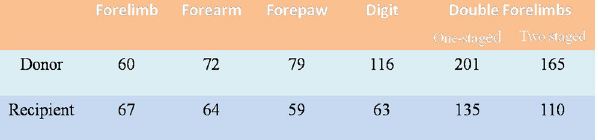
thoracoacromial, and thoracicdorsal vessels. The anatomical locations and diameters of the axillary vessels were consistent. They could also be used as a vascular pedicle for the forelimb, forearm, forepaw and digit ectopic implantation. The main vessels supplying the forearm part are branches from the axillary vessels extending to the elbow, as well as the branches of the brachial vessel including deep brachial vessels, some small branches to the elbow joint, and cutaneous branches to the overlying skin. The anatomical location of the pedicle was superficial and consist- ent. The pedicle was approximately 3 cm in length, making it easier for anastomosis use. The major vessels supplying the forepaw were branches from the axillary vessels and brachial vessels extending to the forepaw. The main branches from the brachial vessel in the forearm region were the median and ulnar ves- sels, whose subsequent branches included the interosseous vessels responsible for partial blood supply for elbow joint, and other branches which supply forelimb muscles. The average length of the pedicle was about 5 cm. The ulnar vessel runs between the ulna and superficial head of flexor digitorum profundus, then accompanies the ulnar nerve to the manus. The median vessel runs along the medium nerve and between the flexor carpi radialis and the superficial head of flexor digitorum profundus. Both vessels became superficial at the distal part of the forearm. The saphenous vessels had three main branches at the inferior margin of the adductor muscles. The most supe- rior of these runs anterior to the tibia and supplies all digits, while the other two branching vessels run medially along the forearm and extend branches to the muscle, joints, and skin. Both run along the tibia nerve and curve posteriorly to the malleolus medialis, then run along the medial side of the plantar surface, where they merge into the medial plantar vessel. The medial plantar vessel divides into four branches at the midpoint of metatarsals, the first of which supplied blood to hallux. The number and location of the vessels that supplied the hallux was consistent. The external jugular vein and the axillary vein merged at the margin of the first rib, which is a very challeng- ing location to isolate and separate the vessels. After entering the chest wall, they are called the left and right vena cava superior, respectively. The ascending aorta, aortic arch, descending aorta, and main branches from the aorta (including the left subclavian, left common carotid, and the brachiocephalic arteries) were easily identified. All vessels within the chest wall had a consistent anatomic location and could be designed as pedicles for the double-forelimb ectopic implantation. Surgical time of harvesting amputated limbs in donors and implanting them in recipients. The average operation time to harvest amputated limbs in donors was about 60, 72, 79, 116, 201, 165 minutes for the forelimb, forearm, forepaw, digit, one-staged double forelimbs and two-staged double forelimbs transplants, respectively. In the recipients, the operation time of implanting the amputated limbs was about 67, 64, 59, 63, 135 and 110 minutes for forelimb, forearm, forepaw, digit, one-staged double forelimbs and two-staged double fore- limbs ectopic implantation, respectively (Fig. 1).